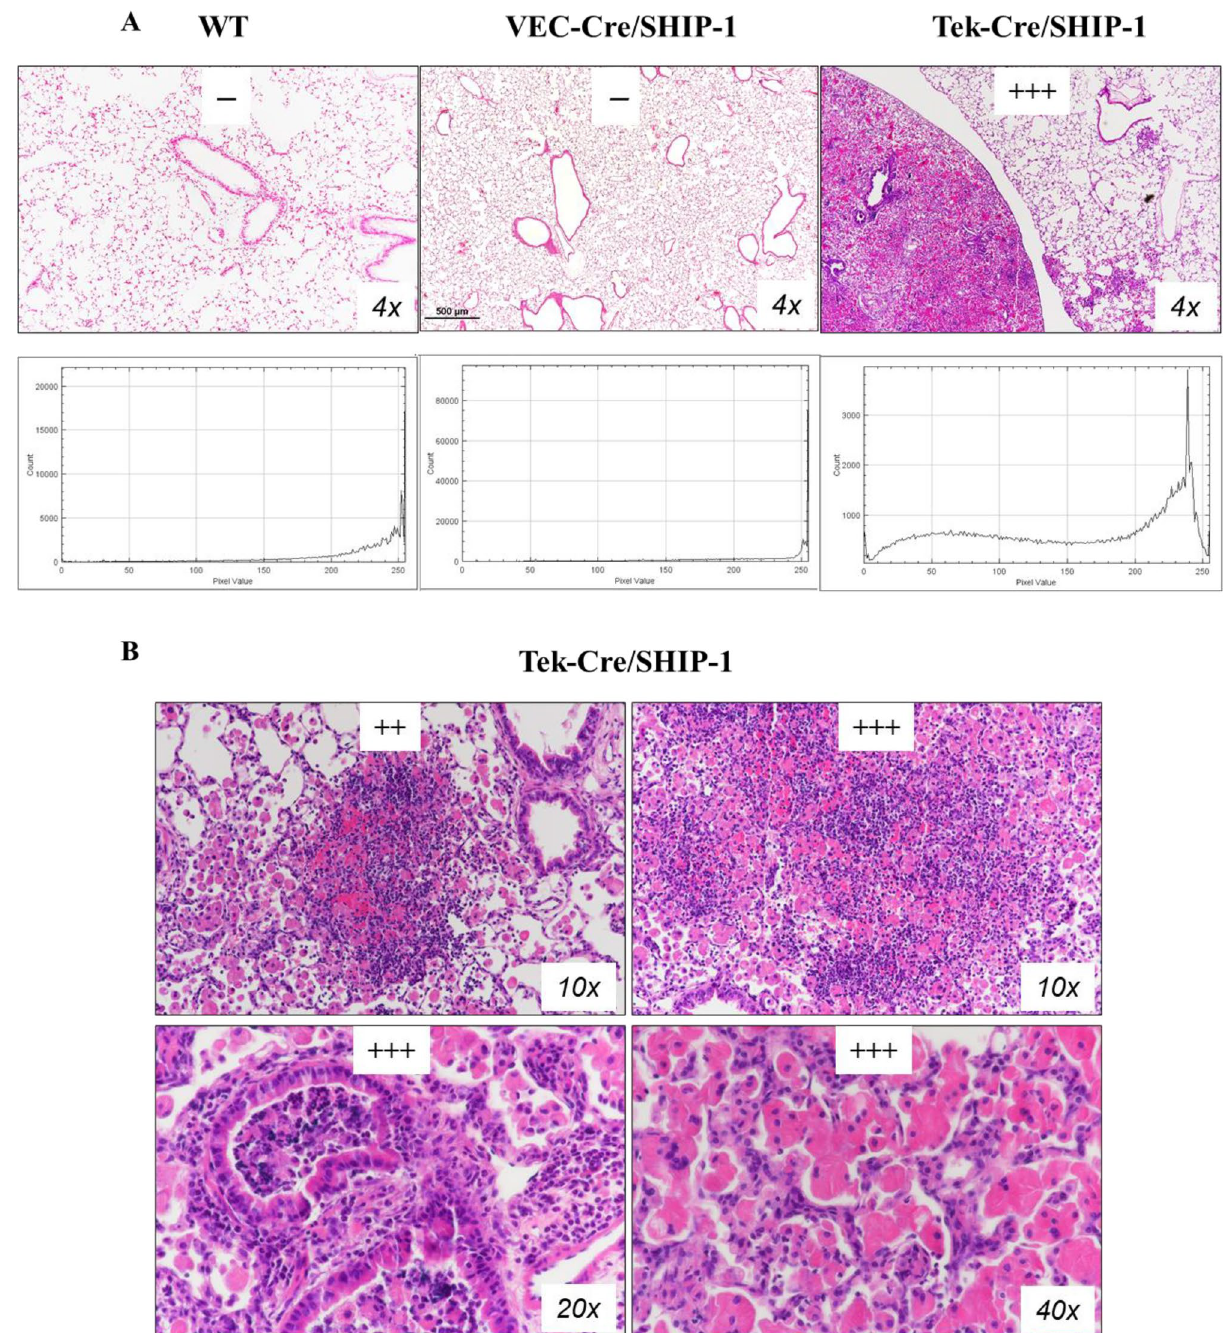
Figure 3. Pulmonary histopathology of Tek-Cre/SHIP-1 mice. Shown are Hematoxylin and eosin (H&E) stained lung sections from ( A ) WT, VEC-Cre/SHIP-1, and Tek-Cre/SHIP-1 mice and ( B ) Tek-Cre/SHIP-1 mice. Lung sections from WT and VEC-Cre/SHIP-1 mice showed normal structure of airways and alveoli. In contrast, mild, medium, and severe cellular infiltration was seen in the airways and lung parenchyma of Tek- Cre/SHIP-1 mice. All Tek-Cre/SHIP-1 mice examined displayed inflammatory lung pathology. Pathology scores were assigned by a pathologist and through application of the NIH ImageJ software and its associated color deconvolution